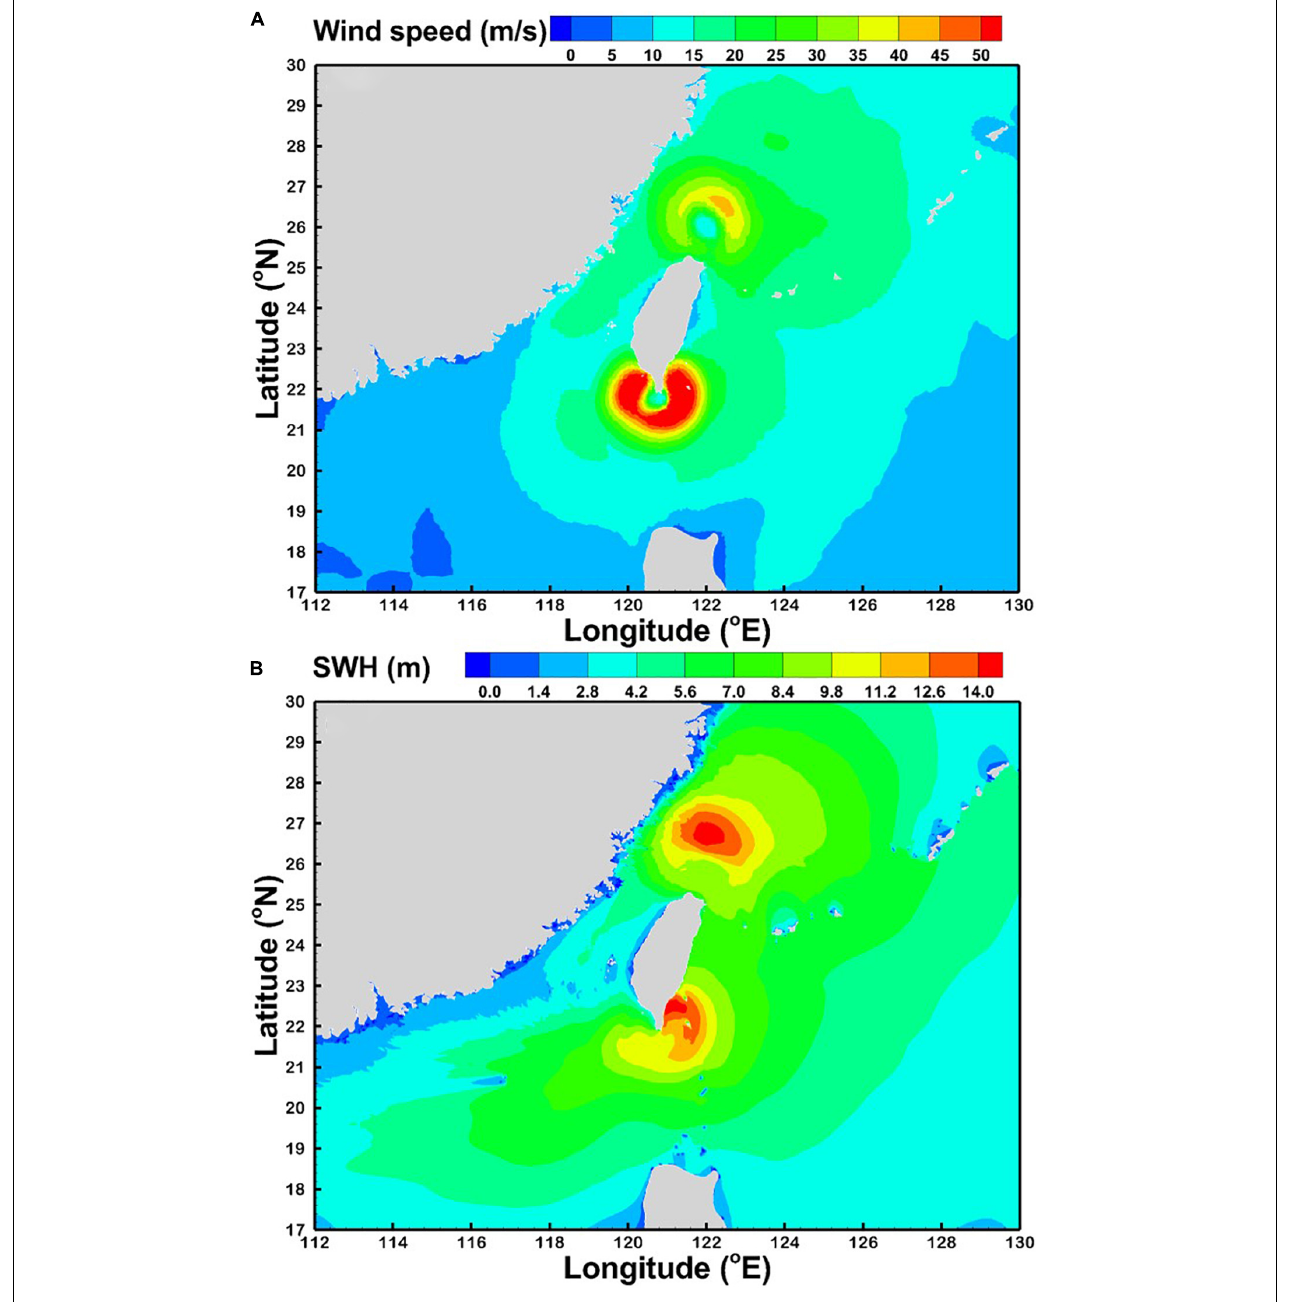
FIGURE 6 | Spatial distribution of (A) the instantaneous wind field from a superposition of Super Typhoons Maria in 2018 and Meranti in 2016 and (B) the corresponding significant wave heights.